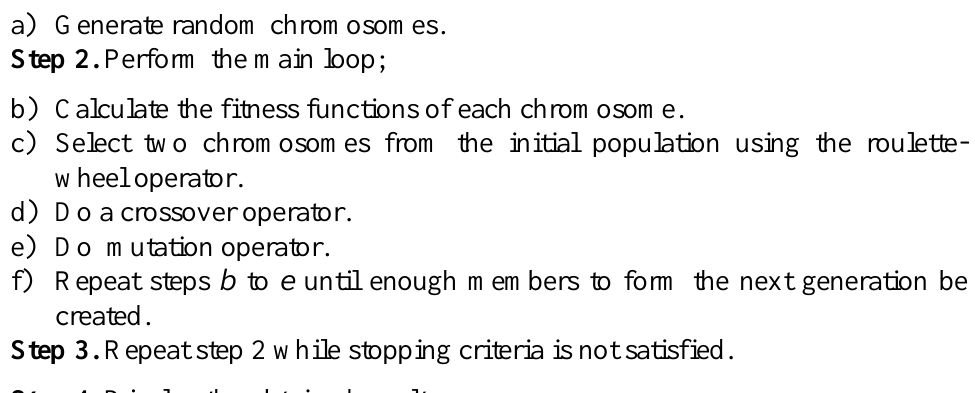
Figure 1. The pseudo-code of the genetic